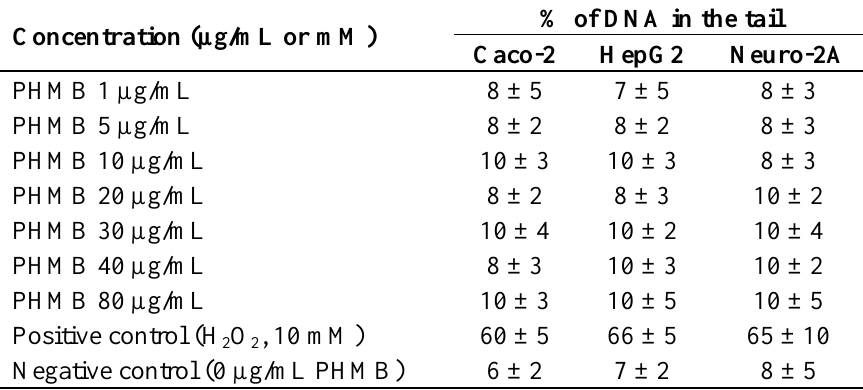
Table 3. Percentage of DNA in the comet tail (comet